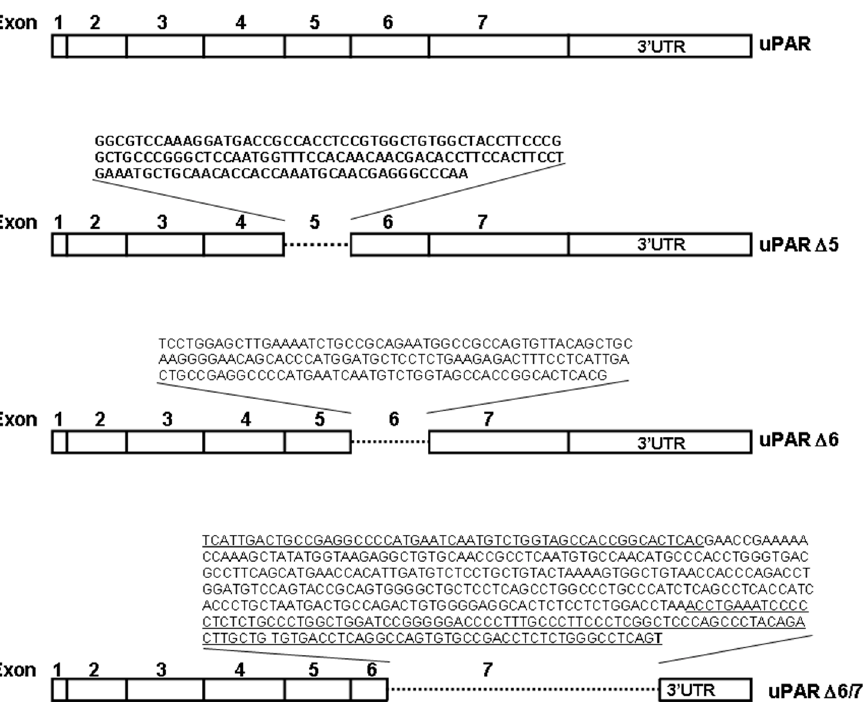
Figure 1. Schematic representation of identified variants of uPAR mRNA. uPAR corresponds to full length uPAR, uPAR ∆ 5 lacks nucleotides (nt) 473–607, uPAR ∆ 6 lacks nt 608–754, uPAR ∆ 6/7 lacks nt length uPAR, uPAR Δ 5 lacks nucleotides (nt) 473–607, uPAR Δ 6 lacks nt 608–754, uPAR Δ 6/7 lacks nt 701–1131 (nt were numbered from the ATG). 701–1131 (nt were numbered from the